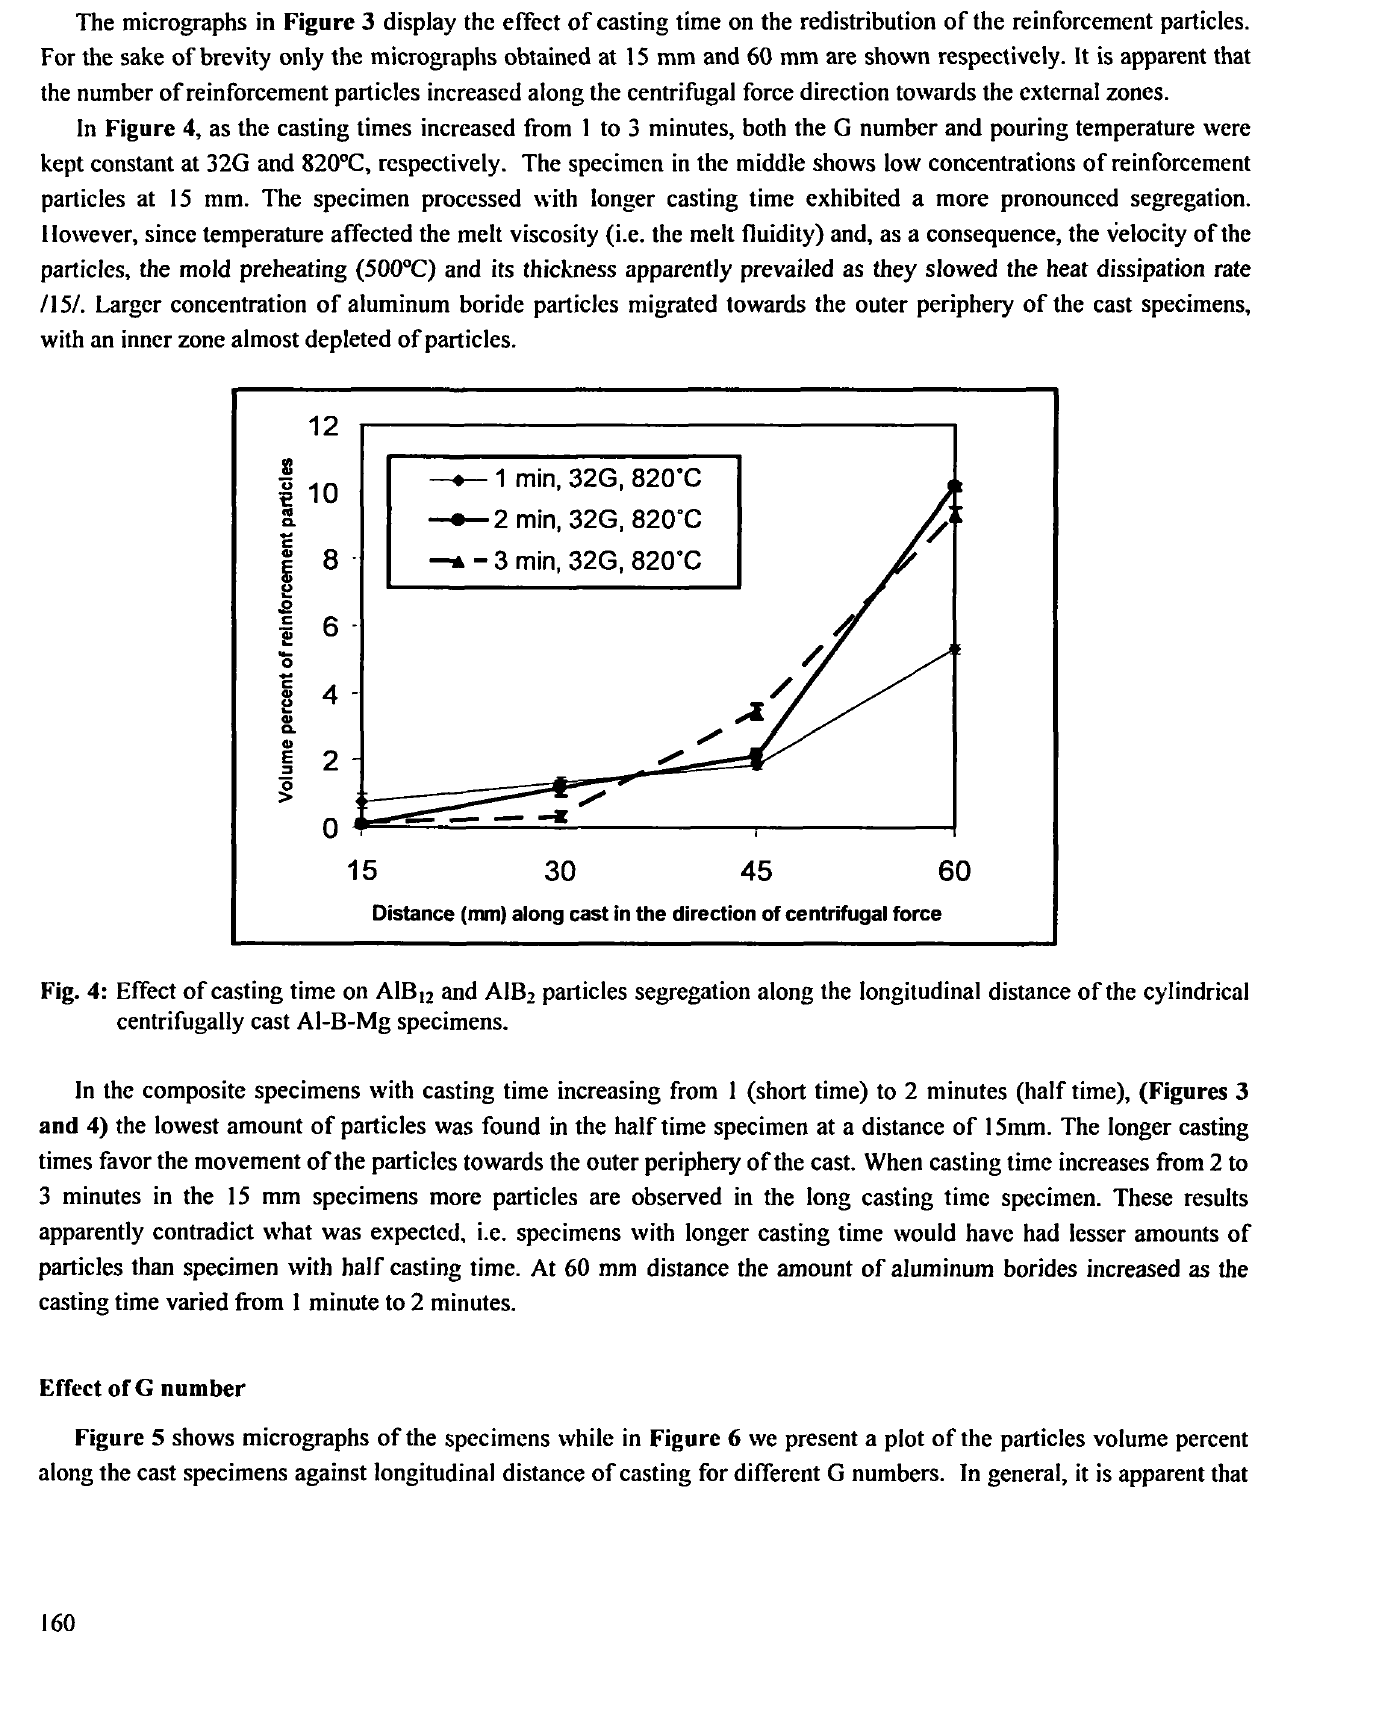
and A1B particles segregation along the longitudinal distance of the cylindrical 2 2